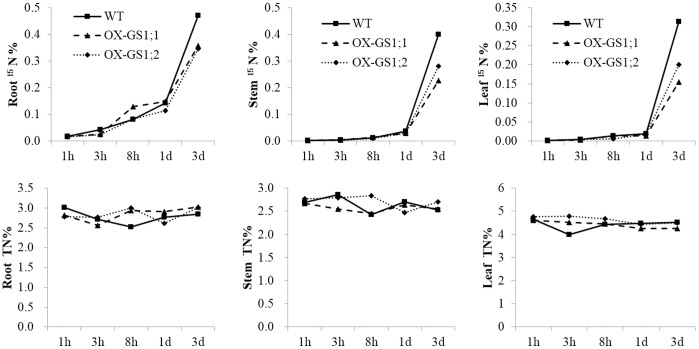
The 15N (15N%) and total nitrogen content (TN%) in the roots, stems and leaves of the GS1;1-, GS1;2-overexpressing plants (OX-GS1;1, OX-GS1;2) and wildtype plants (WT) at 1 h, 3 h, 8 h, 1 d and 3 d after NH4NO3 in the nutrient solution was replaced with 15NH4
15NO3 during the tillering stage.Values are the means from six randomly mixed plant materials.